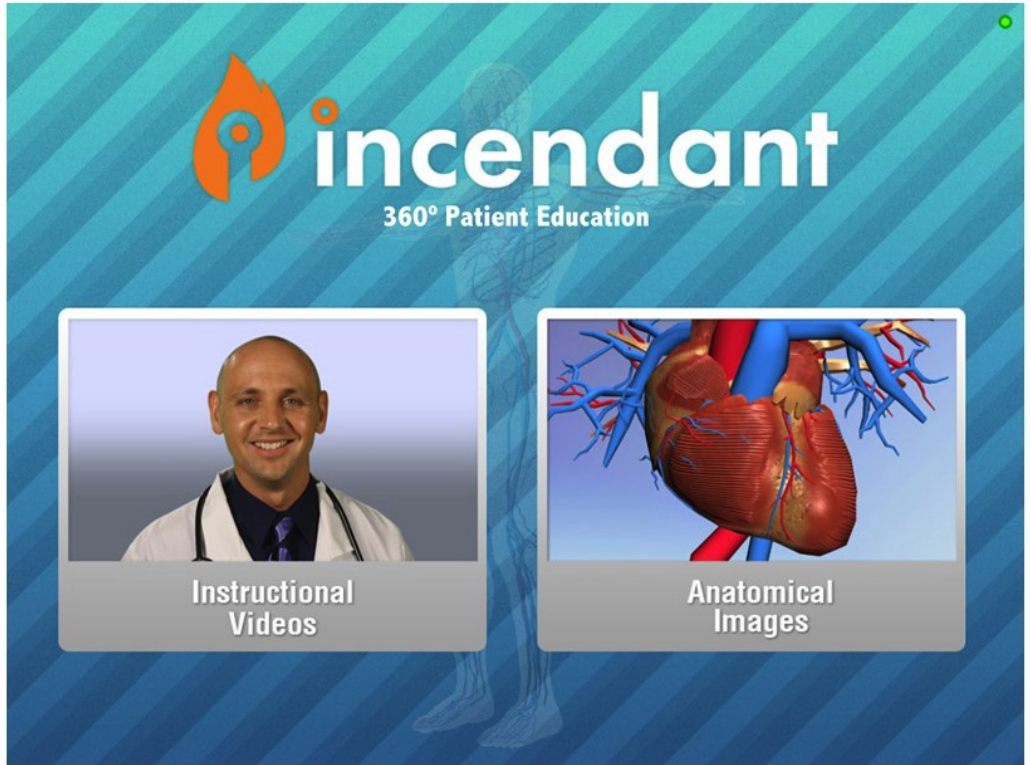
Figure 1. System screenshot